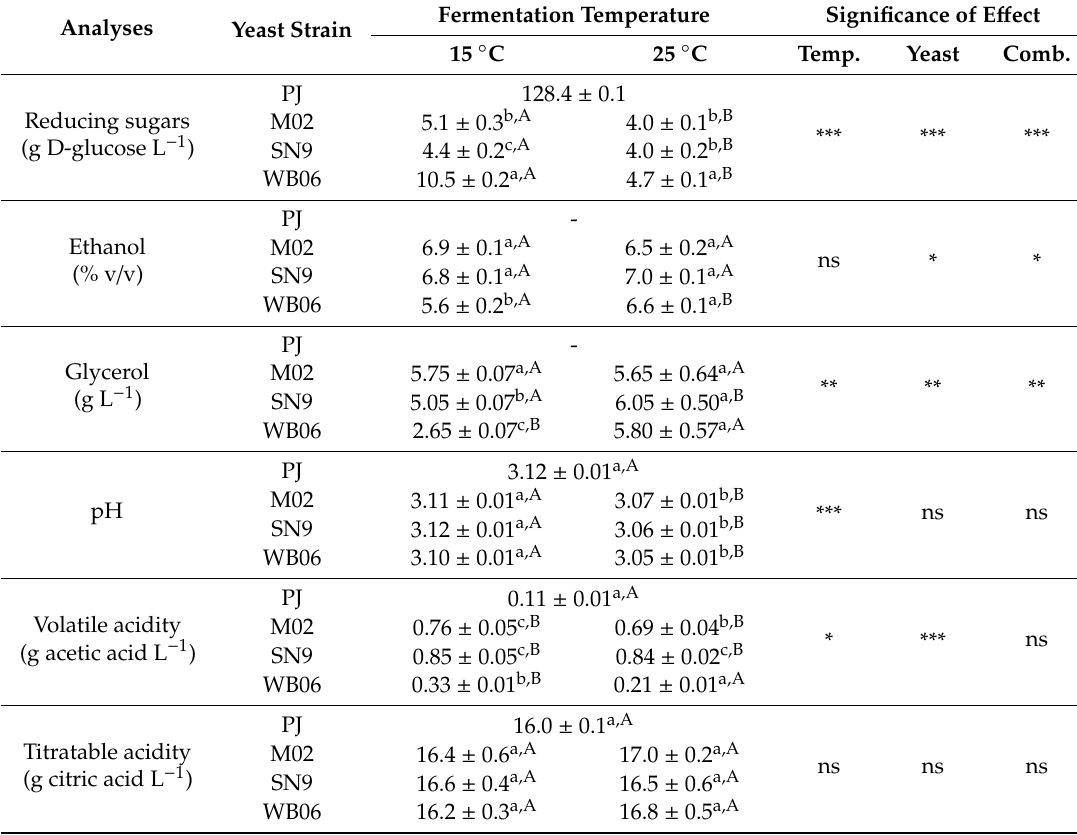
Table 1. E ff ect of yeast and fermentation temperature on the physicochemical characteristics of pomegranate alcoholic